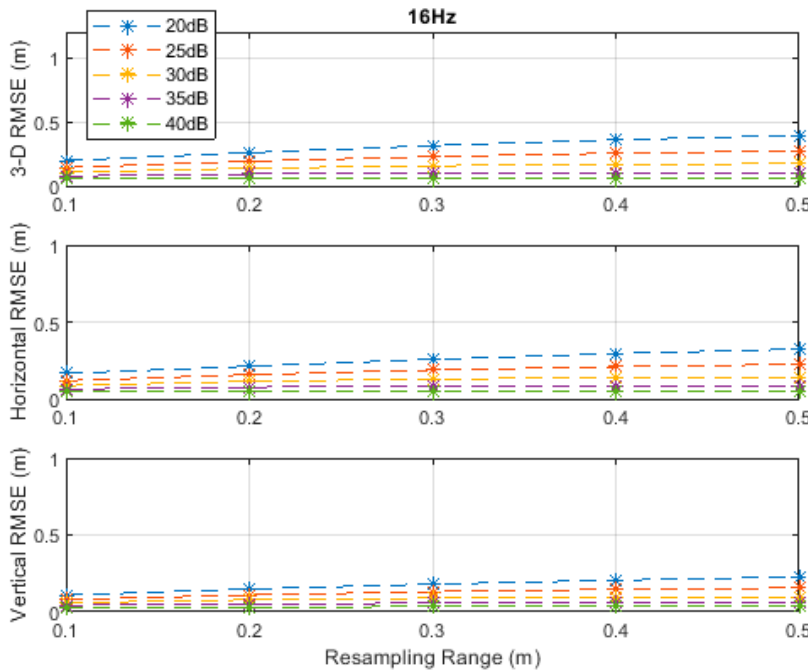
Figure 13. RMSE results along the horizontal circular path at a measurement update rate of 16 Hz.